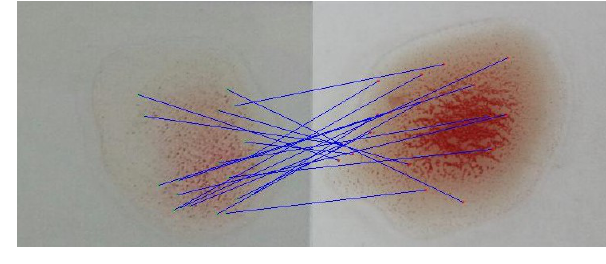
Figure 21. Feature points matching between the anti-D blood spot and both the original reference image and the additional one using the ORB